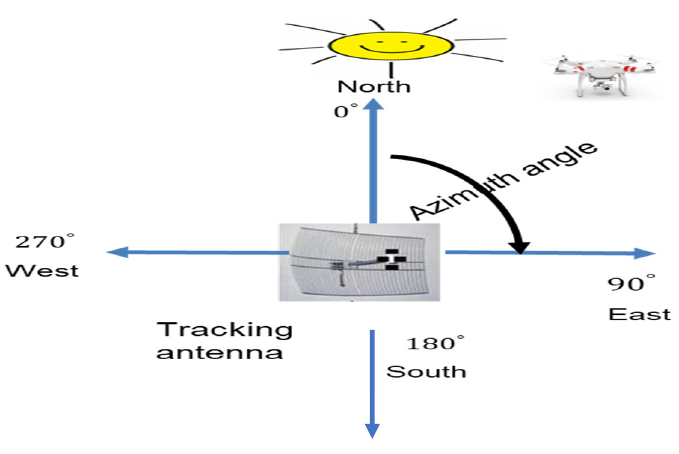
Figure 11. Azimuth angle.